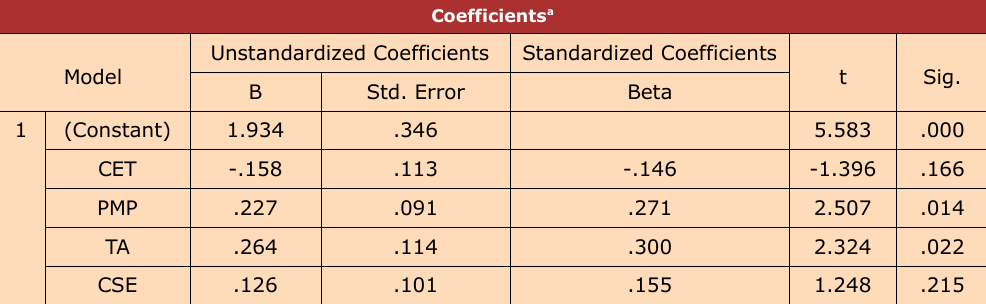
Table 6. Regression Analysis of the dimensions of SI and